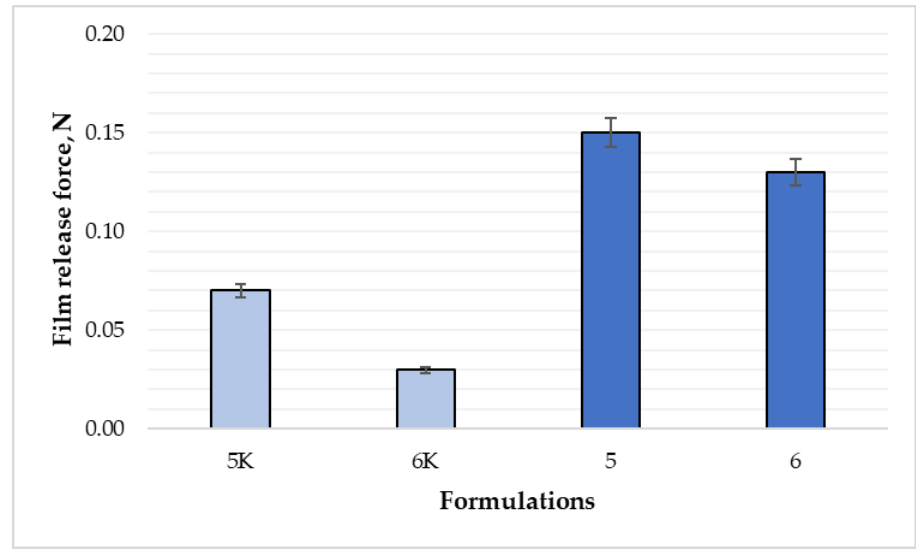
Figure 6. Comparison of film adhesion between formulations (n = 6). The composition values are given in Table 1. p < 0.05 between 5 and 5K; 6 and 6K compositions.